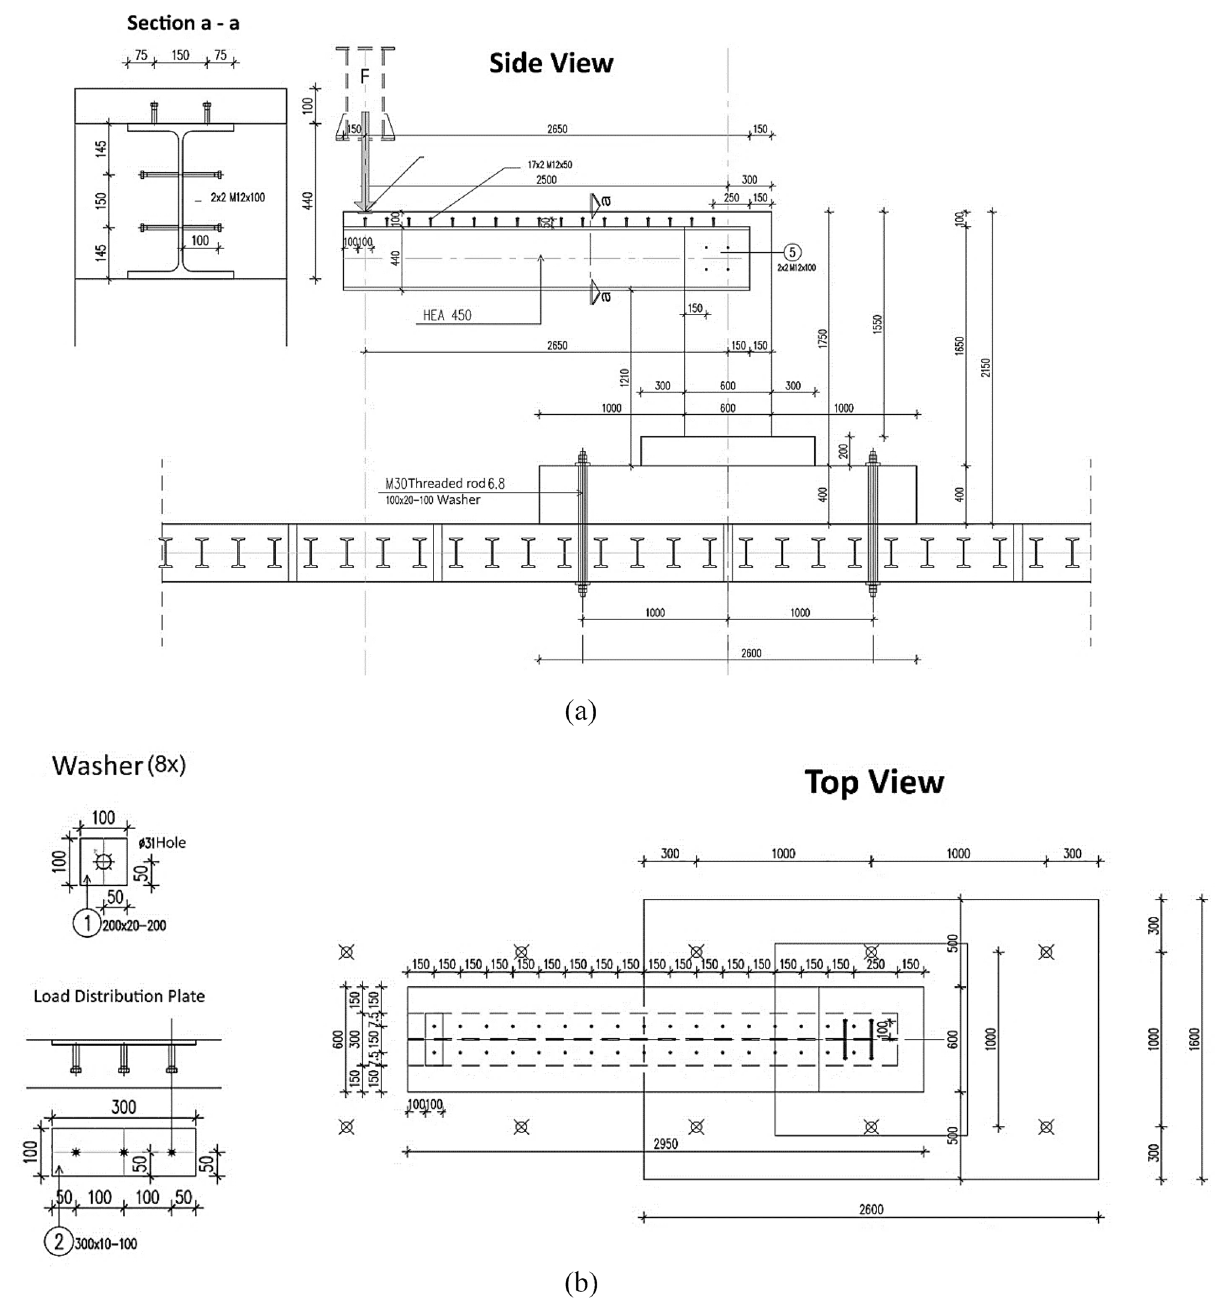
Figure 2. Geometry of the specimen: ( a ) Side view, ( b ) Top